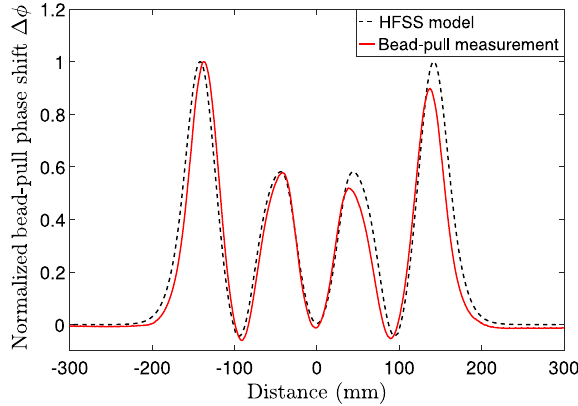
FIG. 9. Normalized phase shift in the S 21 signal obtained during the bead pull at the frequency corresponding to the X 2 mode. For comparison, the phase shift simulated in HFSS is